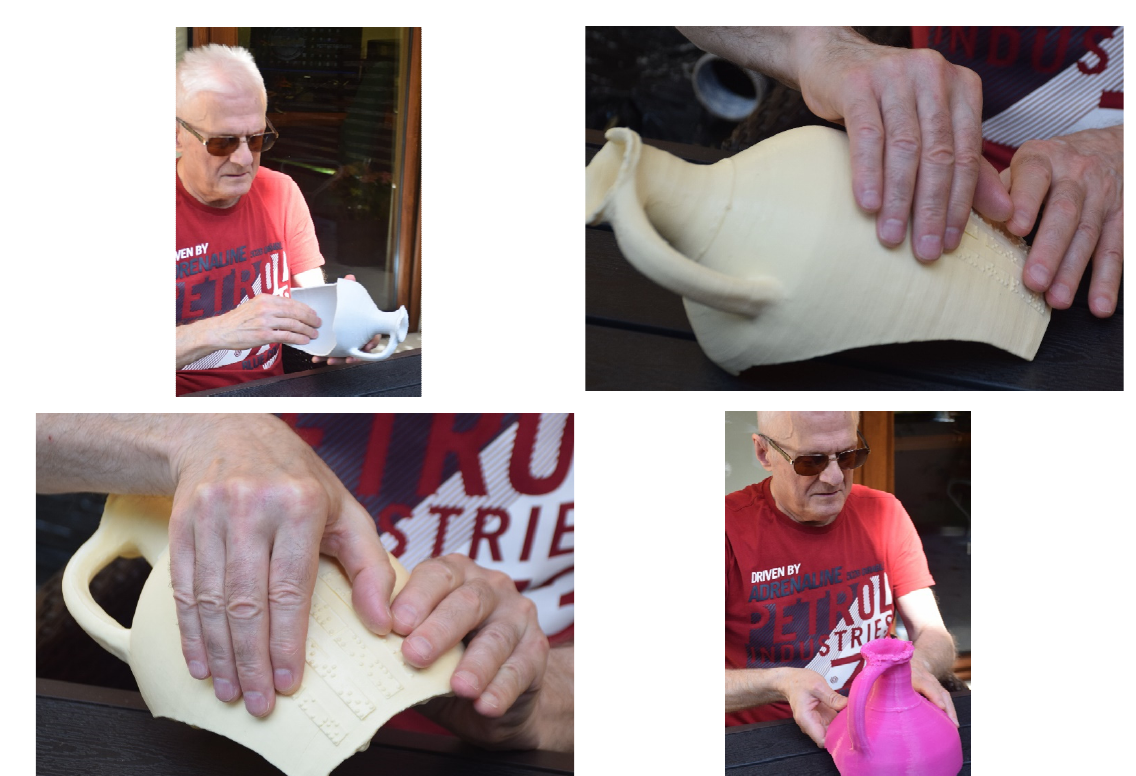
Figure 13. Research with the participation of a blind person.